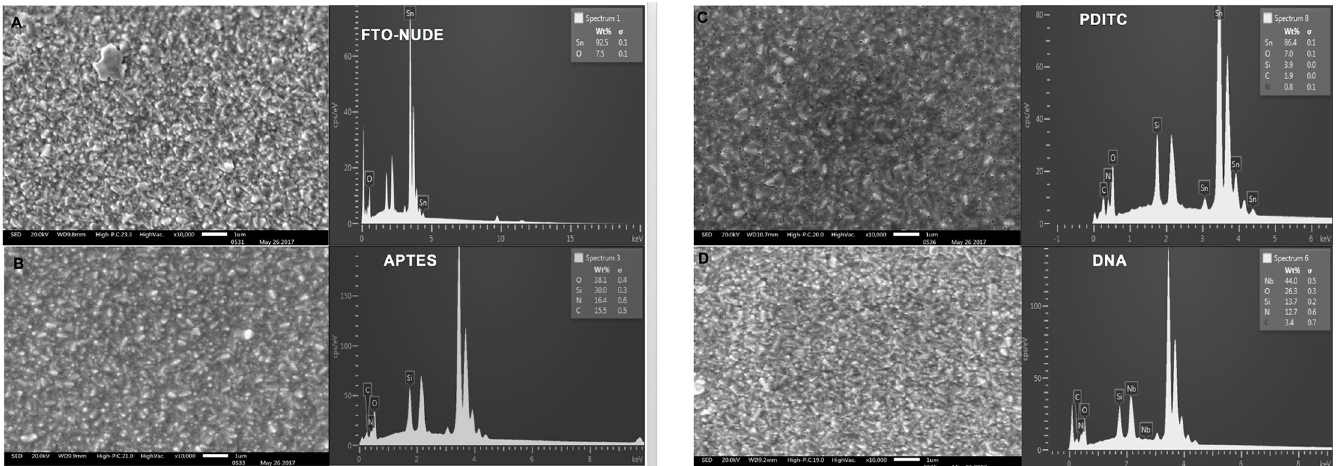
Fig 1. (A) SEM Microscopy SEM 10000x 15 kV FTO-GLAS Clean, FTO-GLASS EDX Analysis (B) Microscopy SEM 10000x 15 kV FTO-GLAS-APTES with their respective diffraction in FTO- GLAS-APTES; (C). Microscopy SEM 10000x 15 kV FTO-GLASS-APTES-PDITC and Diffraction; (D). Microscopy SEM 10000x 15 kV FTO-GLAS-APTES-PDITC-DNA and